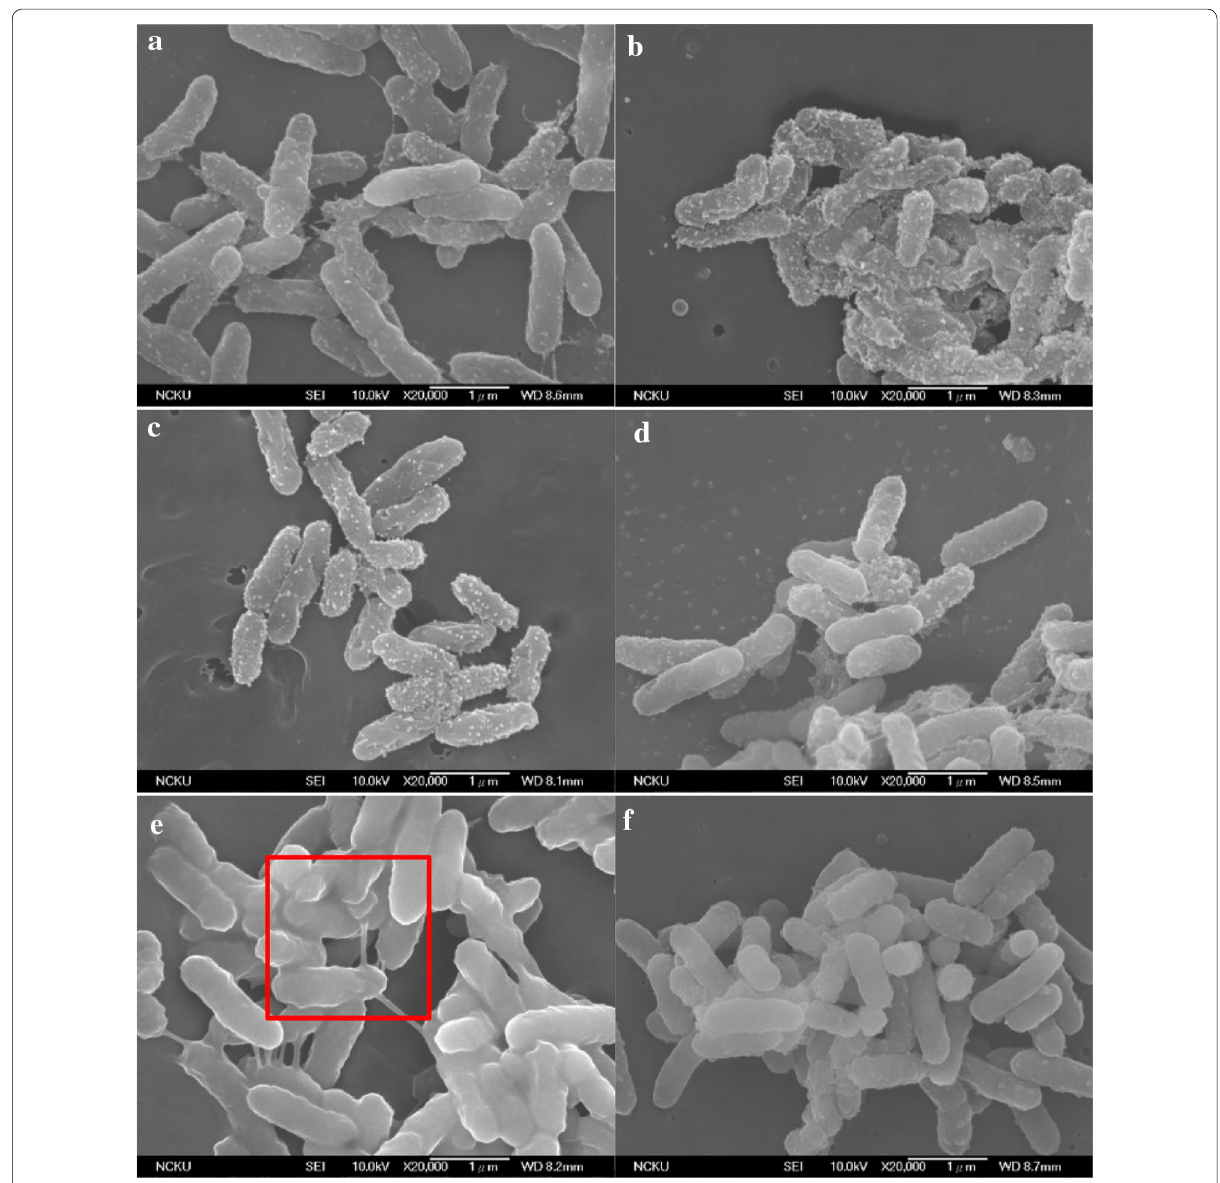
Fig. 2 SEM analysis of SXM at biomass of a 0.6 g/L, c 2.4 g/L, and e 6.0 g/L, and of MR‑1 at b 0.6 g/L, d 2.4 g/L, and f 6.0 g/L when immersed in 300 ppm Au